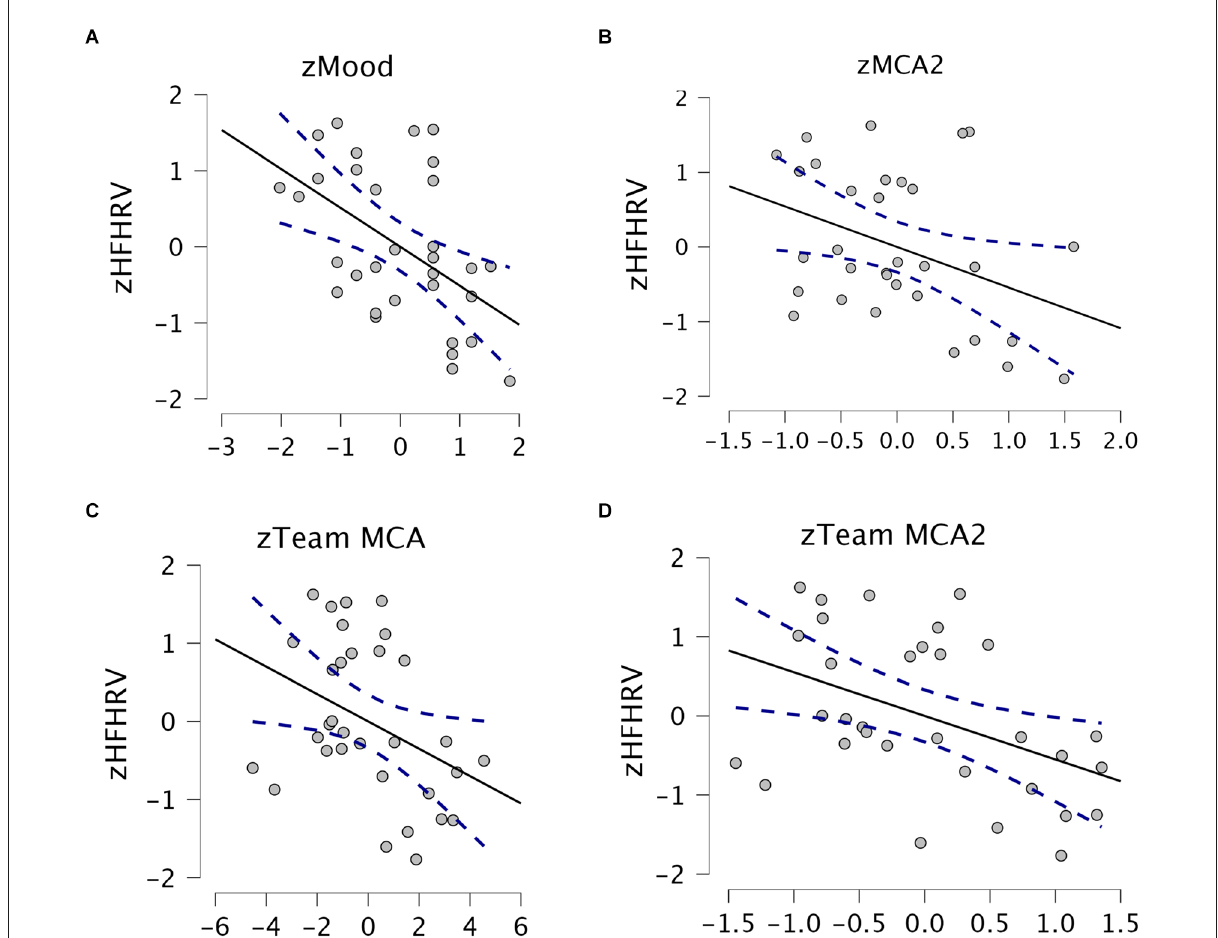
FIGURE5 Scatter plots with regression lines. Stapled lines are 95% confidence intervals. (A) HFHRV and mood. (B) HFHRV and MCA2. (C) HFHRV and team MCA. (D) HFHRV and team MCA2. HFHRV, High frequency component heart rate variability; MCA, Metacognitive accuracy; MCA2, MCA without Kill chain